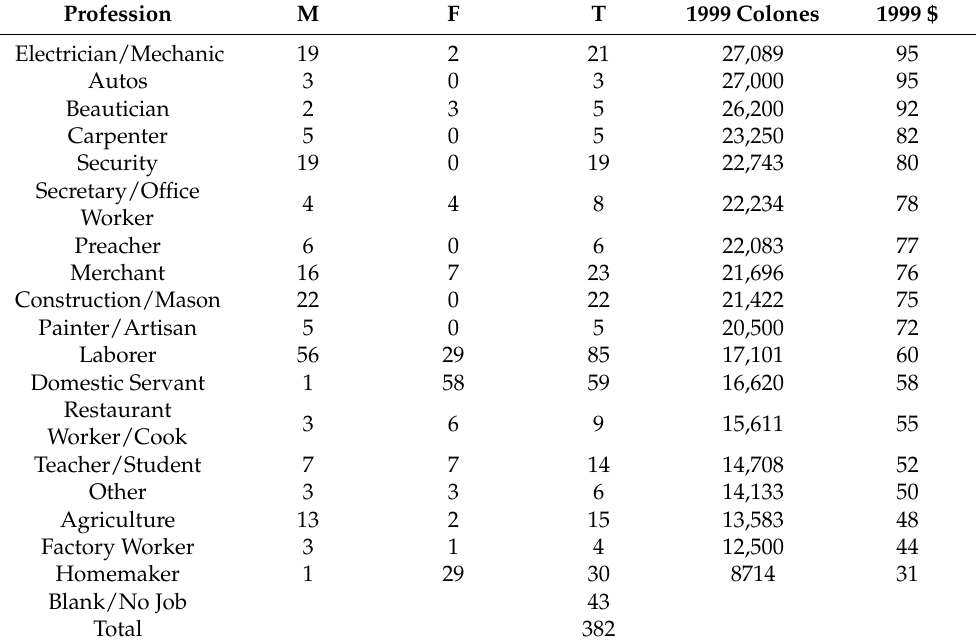
Table 2. Reported professions and weekly salaries of 1999 Costa Rica Survey